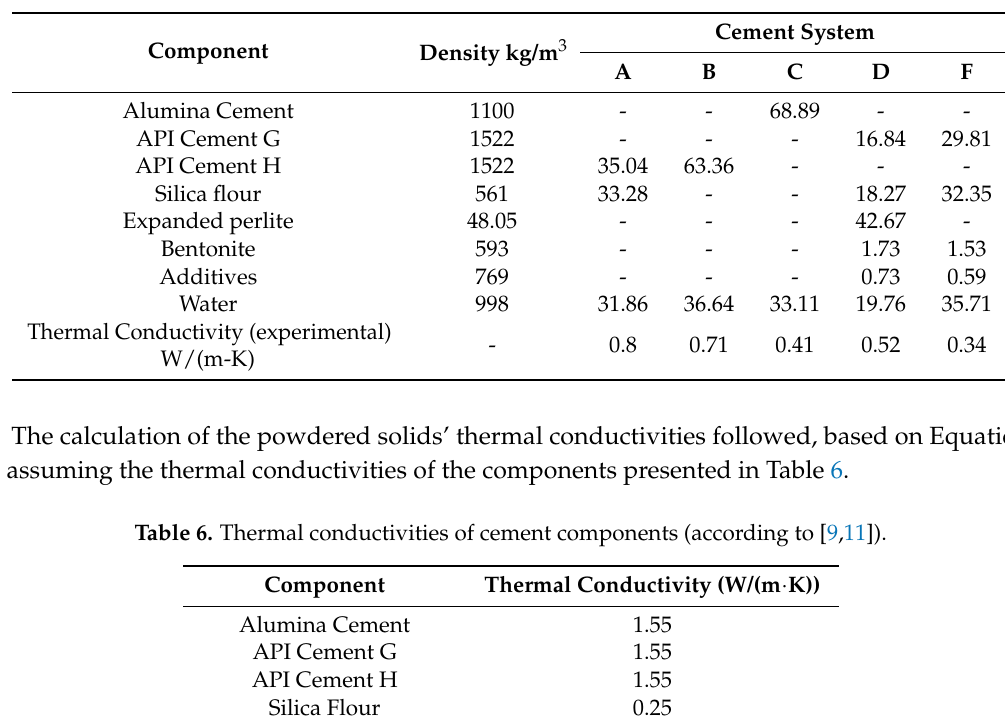
Table 5. Cements composition (in percent by volume).